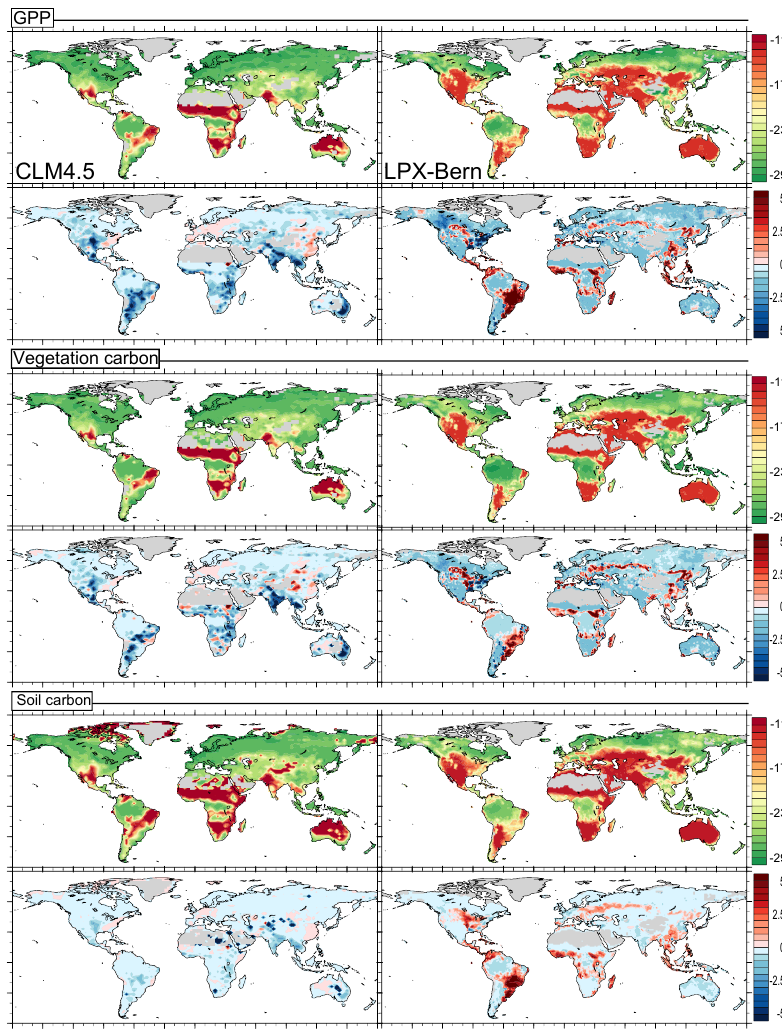
Figure 4. δ 13 C (‰) of GPP, vegetation carbon and soil carbon in the year 2000 (top) and the change from 1900 to 2000 (below). The estimates are based on decadal means (1896–1905 and